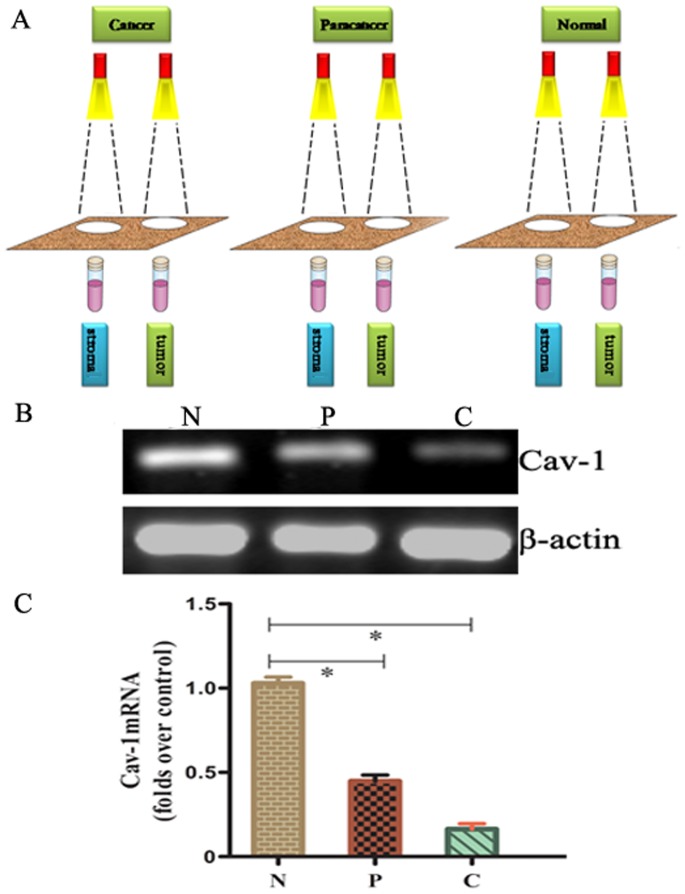
The mRNA expression of stromal Cav-1 in laser-captured samples by RT-PCR and Real-time PCR.
A: Schematic diagram representing the LCM technique. B: mRNA expression of stromal Cav-1 in laser-captured samples as determined by RT-PCR. C: Quantification of mRNA by real-time quantitative PCR. Data from at least three independent experiments with duplicate determinations are expressed as means ± SEM. (N) Normal tissue; (P) Paracancer tissue; (C) Tumor tissue. *P<0.05 was considered statistically significant.